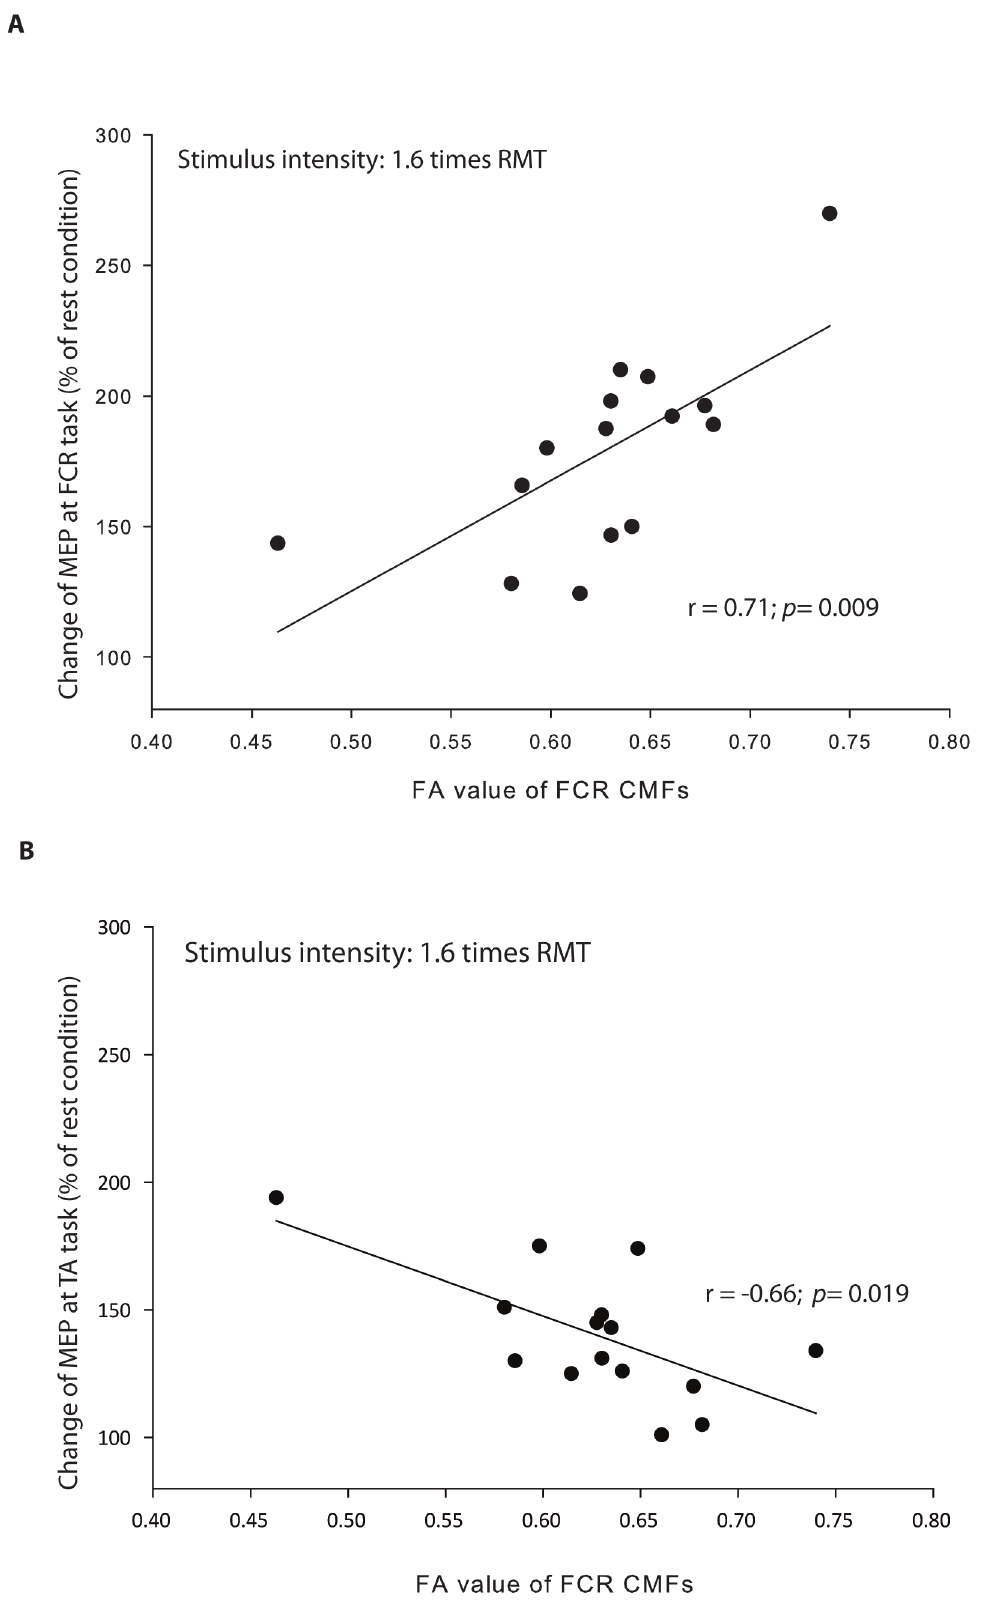
Figure 3. Linkage of callosal motor fibers (CMFs) with functional changes in M1 ipsilateral representation during unilateral movement. The fractional anisotropy (FA) of the FCR CMFs is associated with the change of MEP at 1.6 times RMT in (A) right wrist flexion and in (B) right ankle dorsiflexion. doi:10.1371/journal.pone.0104218.g003 PLOS ONE |